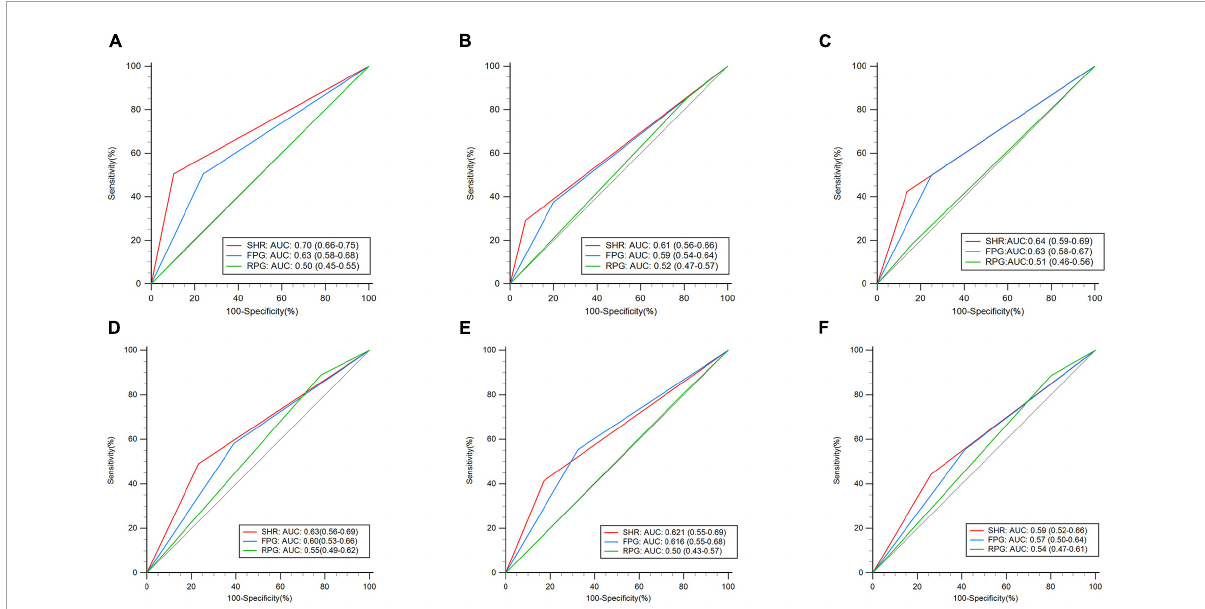
FIGURE3 Receiver operating characteristic curve (ROC) analyses of the stress hyperglycemia ratio (SHR), admission fasting plasma glucose (FPG), and admission random plasma glucose (RPG) as binary variables for the prediction of outcomes. Training dataset: (A) moderate-to-severe cerebral edema (CED), (B) 90-day poor functional outcome, and (C) 90-day death. Validation dataset: (D) moderate-to-severe CED, (E) 90-day poor functional outcome, and (F) 90-day